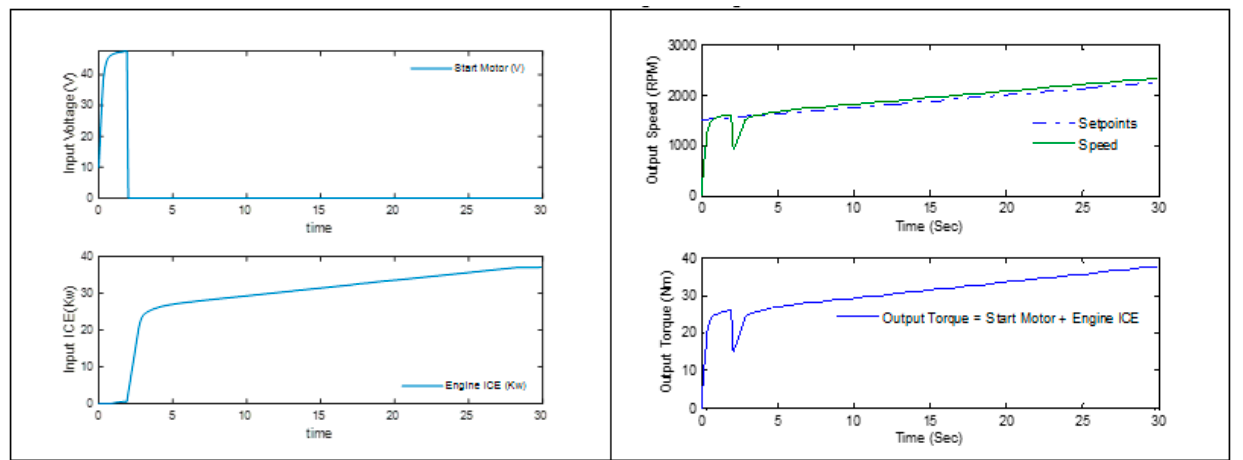
Figure 10. The MPC for the HEV propelled by only ICE.